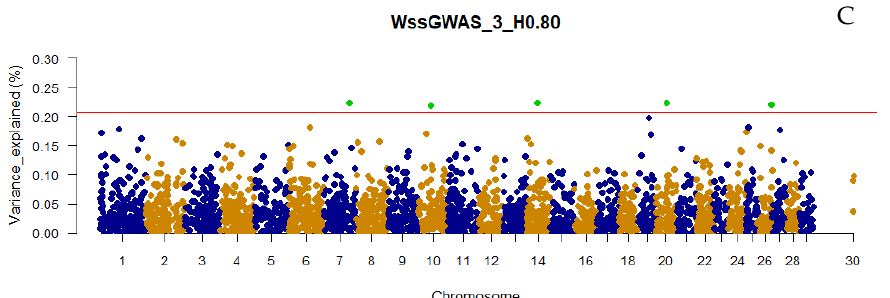
Figure 4. Manhattan plot of the percentage of the total additive genetic variance explained by haplotypes from haploblocks built with a linkage disequilibrium threshold of 0.80 for yearling temperament in American Angus cattle using single-step GWAS (ssGWAS_H0.80; A ) and weighted single-step GWAS in the second (WssGWAS_2_H0.80; B ) and third (WssGWAS_3_H0.80; C ) iterations. Green points highlighted above the red horizontal line are the top 0.001% markers that explained greater percentages of the total additive genetic variance for YT. The X-chromosome (PAR region) is represented by the chromosome 30.